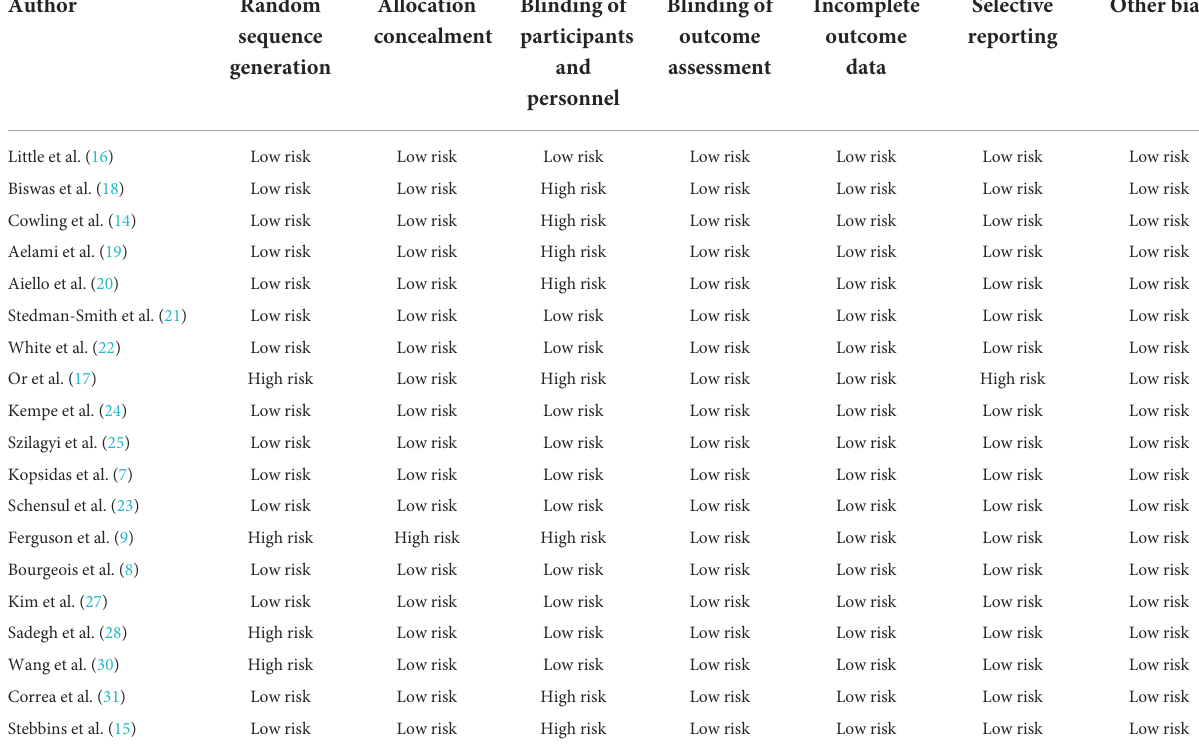
TABLE 5 Quality assessment of the experimental studies included in the meta-analysis (the Cochrane